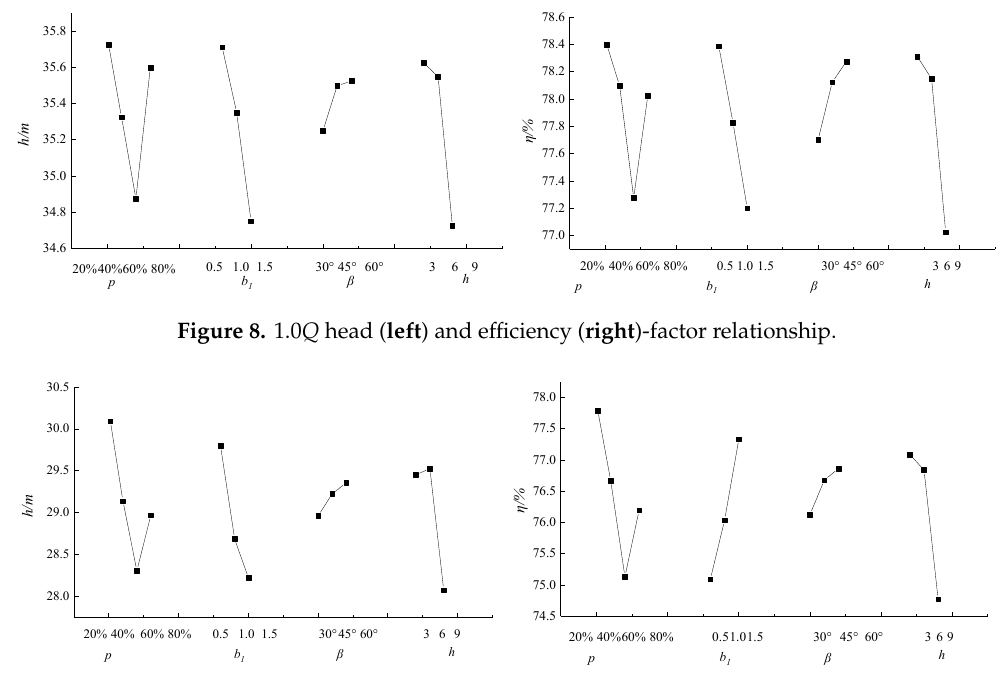
Figure 9. 1.4 Q head ( left ) and efficiency ( right )-factor relationship.